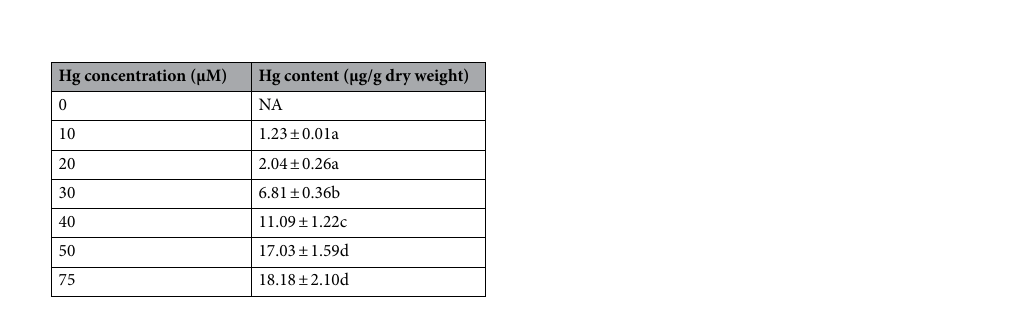
Table 2. The Hg accumulation of S. caninervis with different treatments of Hg after 7 days. Data are means with standard errors (n = 3), different lowercase letters indicate a significant difference among seven Hg treatments after 7 days ( p <